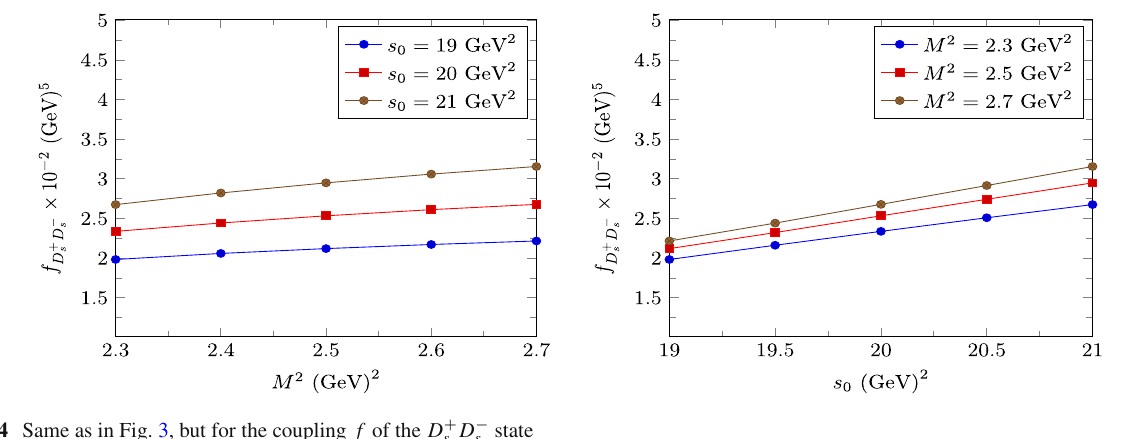
Fig. 4 Same as in Fig. 3, but for the coupling f of the D + s D − s state